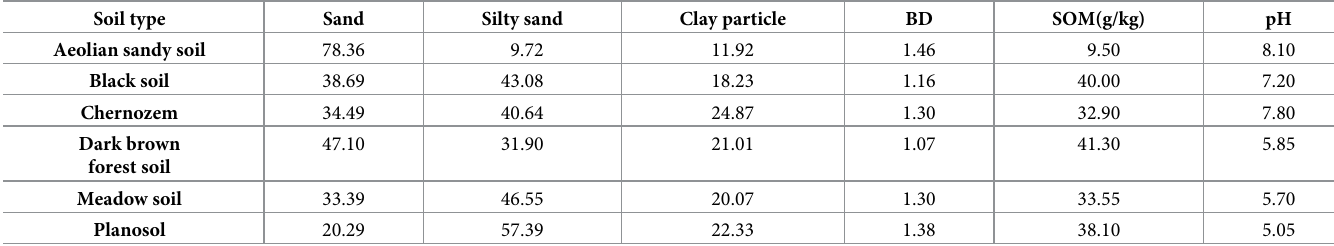
Table 3. General information of different soil